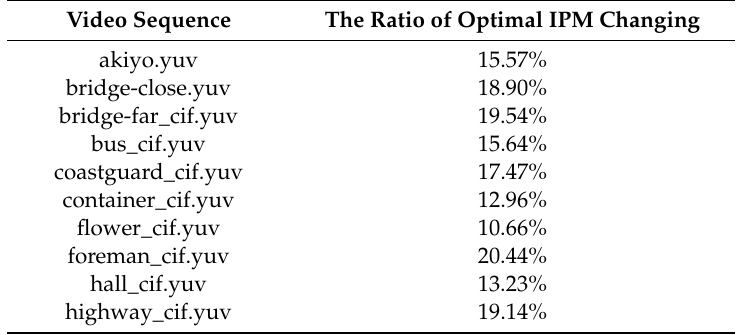
Table 1. Experimental results of the adaptive steganography embedding strategy. Video Sequence